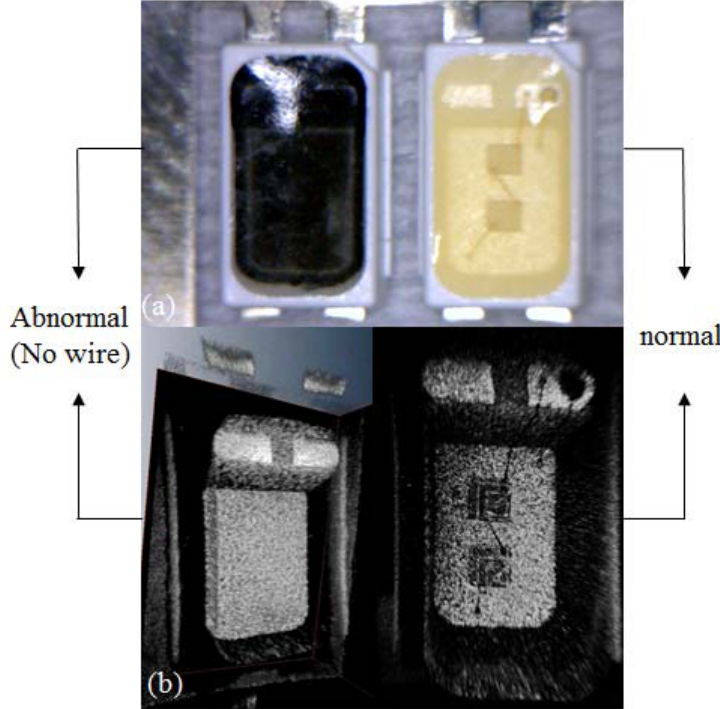
Figure 7. Comparison of digital microscope and OCT images of faulty and normal LED. ( a ) Abnormal (no wire) and normal LEDs digital microscope image; ( b ) Abnormal (no wire) and normal OCT image.